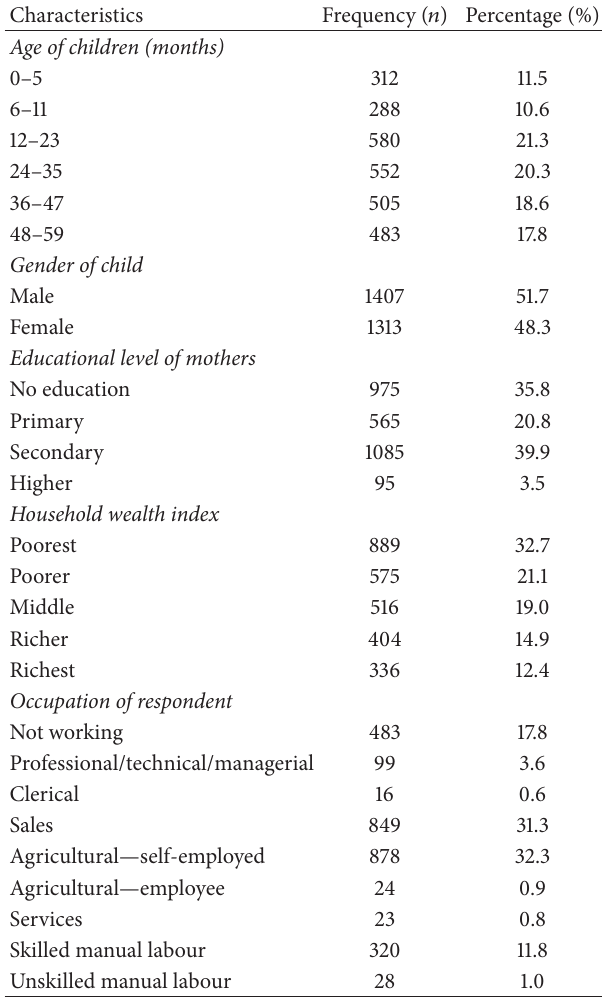
Table 1: Sociodemographic characteristics of sample ( 𝑁 = 2 , 720